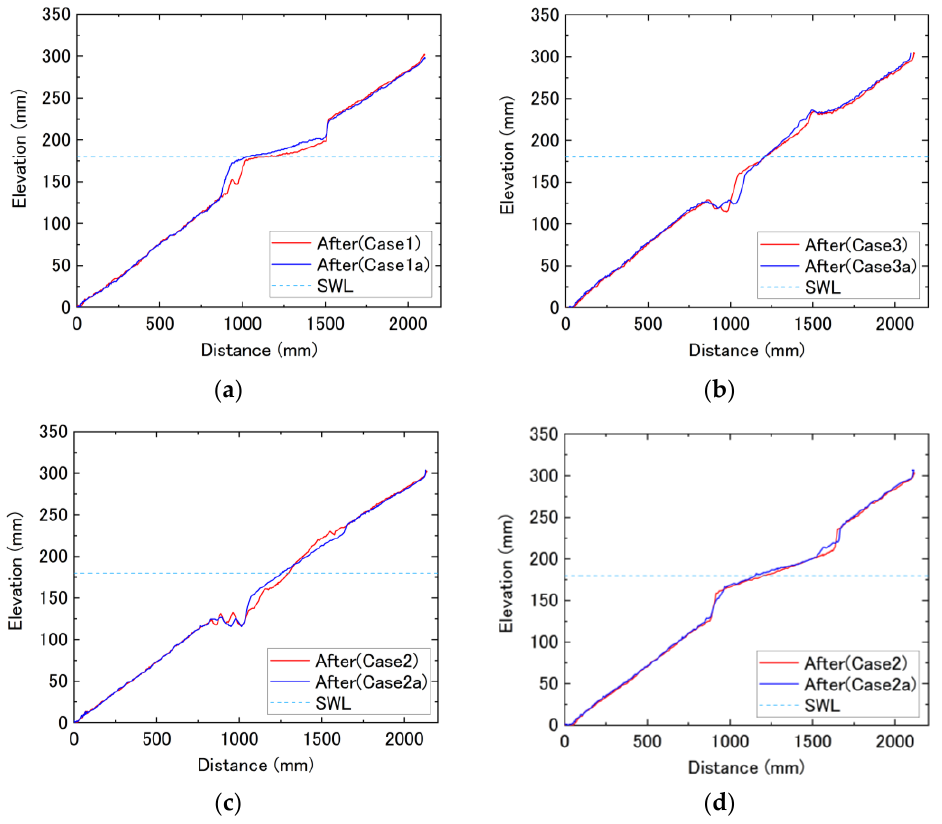
Figure 8. Topographical changes before and after the experiment: measurement of ( a ) cross-section 1 of case 1a, ( b ) cross-section 1 of case 3a, ( c ) cross-section 1 and ( d ) cross-section 2 of case 2a.